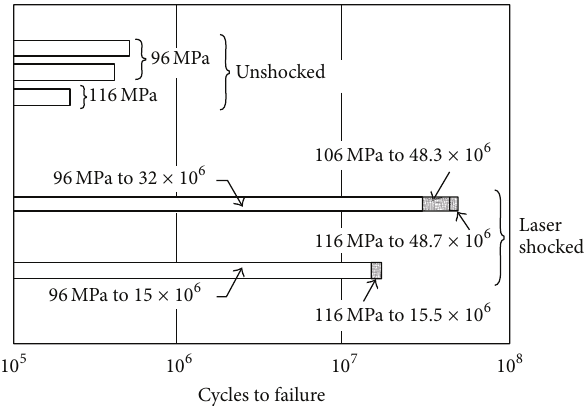
Figure 14: Increased resistance to ferreting fatigue around fastener holes after laser shock peening aluminum 7075-T6 [62].